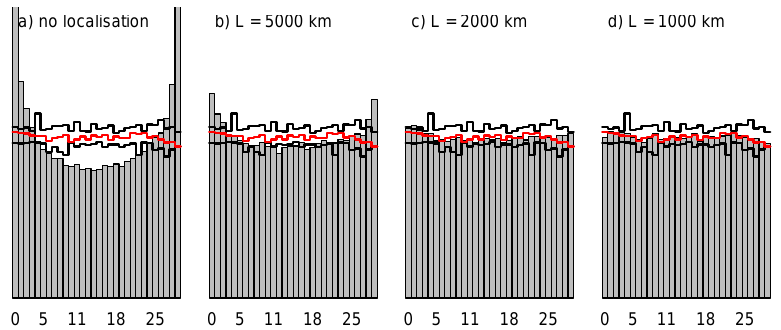
Fig. 4. Rank histogram of the reference simulation compared to the analysis using different lengths for the covariance localisation. Without covariance localisation, the spread of the ensemble is negatively biased, leading to a strongly U-shaped rank histogram. The black lines are empirical confidence intervals from a cross-validation with the unconstrained ensemble, using each of the 30 simulations as observations in turn (see text for further discussion). The red line indicates the rank histogram of the reference simulation against the unconstrained ensemble. The scale on the y-axis is the same for all plots, and the frequency of occurrence of ranks 0 and 29 are clipped in (a) .